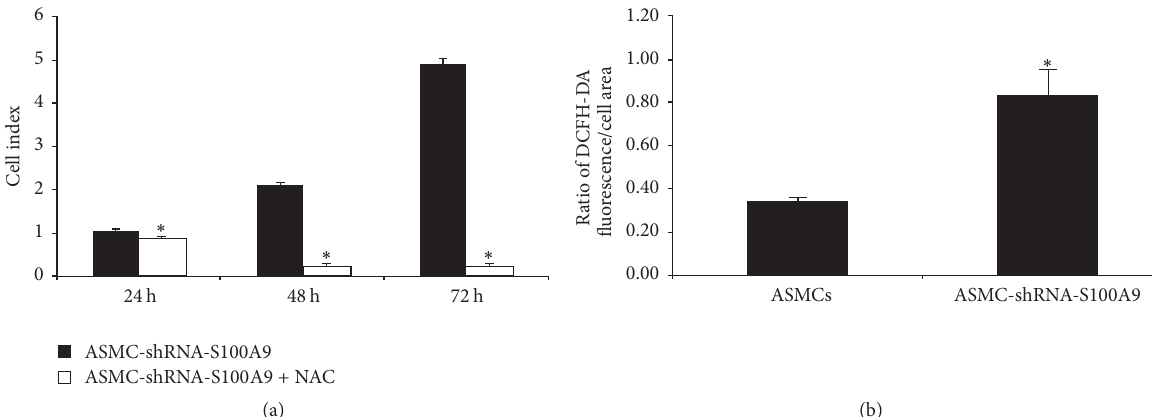
Figure 3: Quantification of oxidative stress in airway smooth muscle cells (ASMCs) with stable knockdown of S100A9 expression (ASMC- shRNA-S100A9). (a) Effects of antioxidative agent N-acetylcysteine (NAC) on ASMC-shRNA-S100A9 proliferation at 24 h, 48h, and 72 h. ∗ indicates a significant difference as compared to control ( 𝑃 < 0.05 ). (b) Comparison of the ratio of DCFH-DA fluorescence to cell area in ASMCs and ASMC-shRNA-S100A9 cells. The fluorescence of forty cells from three microscope fields was measured and the assay was repeated in triplicate. ∗ indicates a significant difference as compared to ASMCs ( 𝑃 < 0.05 ). All data are presented as the means ± SD.